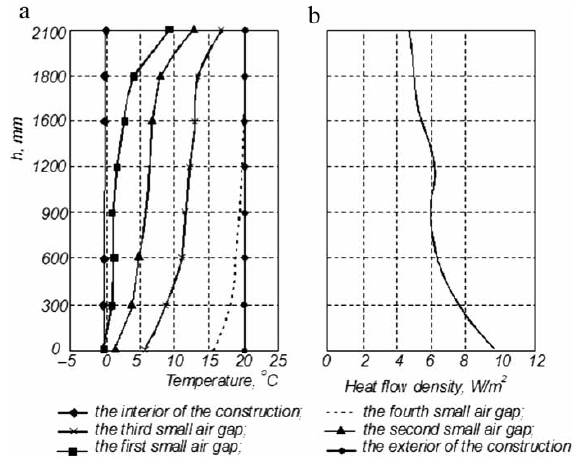
Fig. 7. Air temperatures (a) and heat flow density (b) in the gaps of the non-ventilated (closed) construction. The sample intheverticalpositionwhen u i (cid:2)(cid:4) 20 8 C, u e (cid:2) 0 8 C, Du (cid:2) 20 8 C